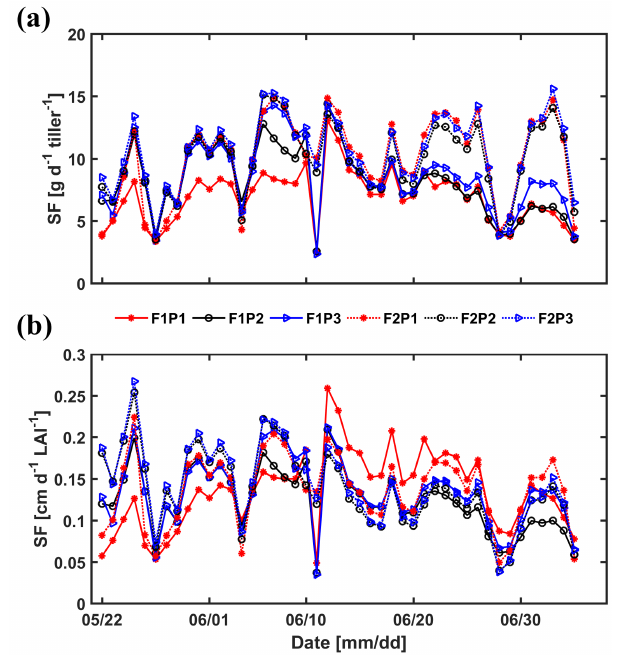
Figure 13. Measured sap flow (SF) per tiller (a) and per unit leaf area index (LAI) (b) in the three plots (P1: sheltered; P2: rainfed; P3: irrigated) of the stony (F1) and silty (F2) soils.